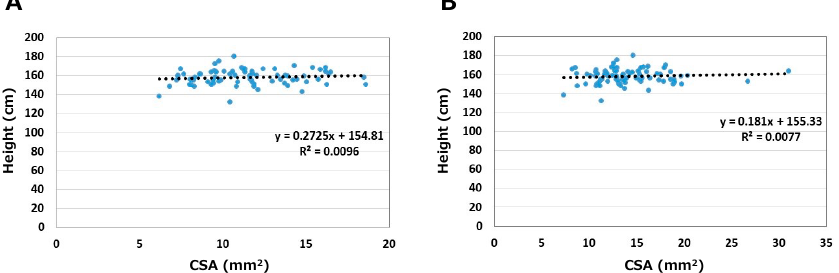
Figure 3. Relationships between height and CSA. ( A ) Asymptomatic side. ( B ) Symptomatic side. The relationships between body weight and CSA are shown in Figure 4. Correlation coefficients were 0.39 on the asymptomatic side and 0.18 on the symptomatic side. Weight medium correlated with CSA on the asymptomatic side only ( p < 0.05).